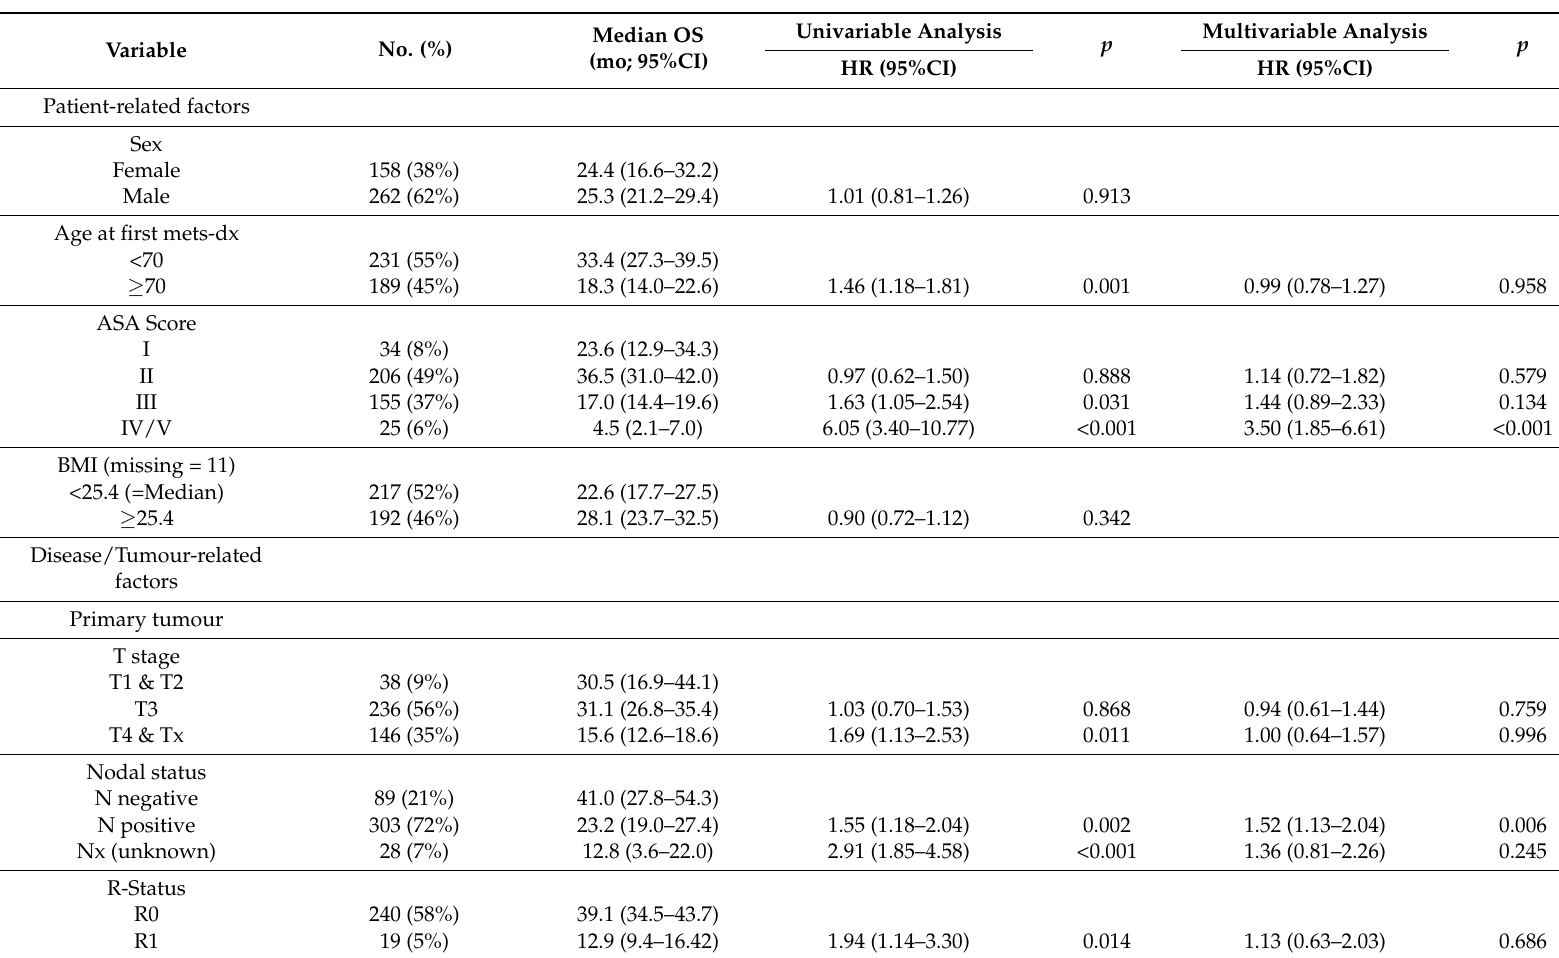
Table 4. Univariable and multivariable analysis of factors associated with overall survival (whole cohort; n =